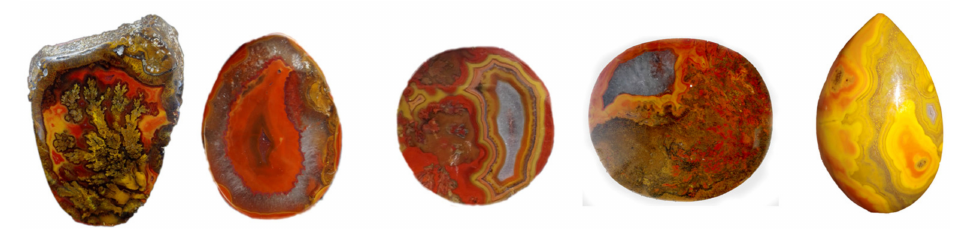
Figure 9. Changeable and charming patterns of the Xuanhua-type